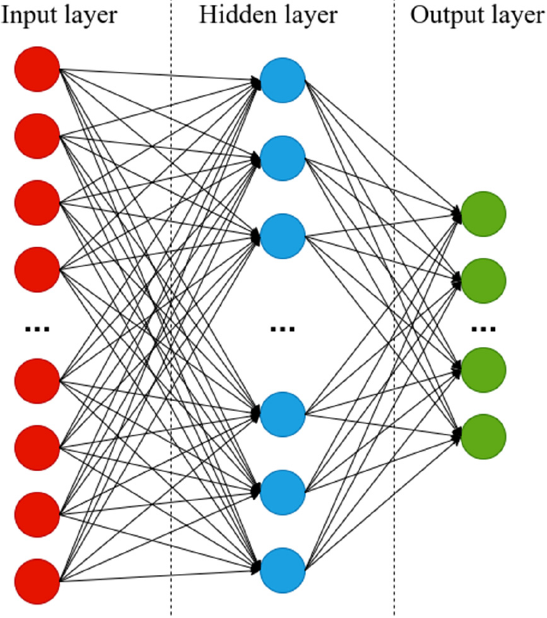
Figure 5. Feed forward neural network with three layers. The final architecture had 20,001 neurons at the input layer, 500 neurons at the hidden layer, 50 neurons at the output layer.